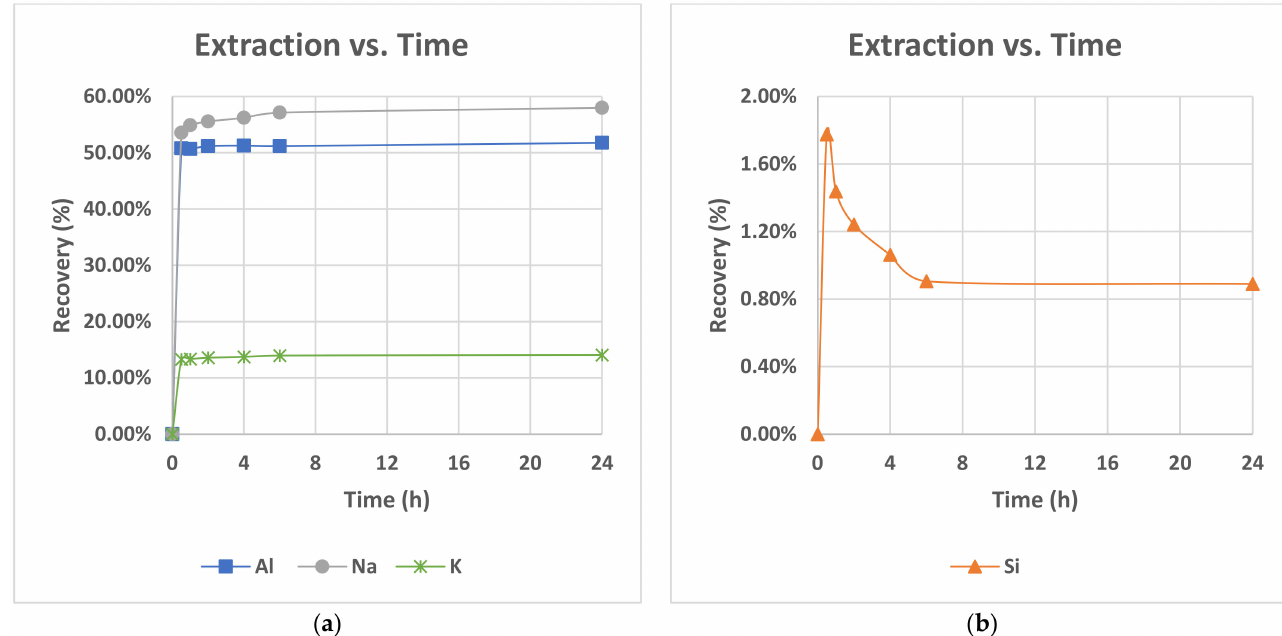
Figure 3. Effect of leaching retention time on the extraction of ( a ) Al, K, Na and ( b ) Si values (stirring rate: 300 rpm, HCl concentration: 5.89 M, temperature: 90 ◦